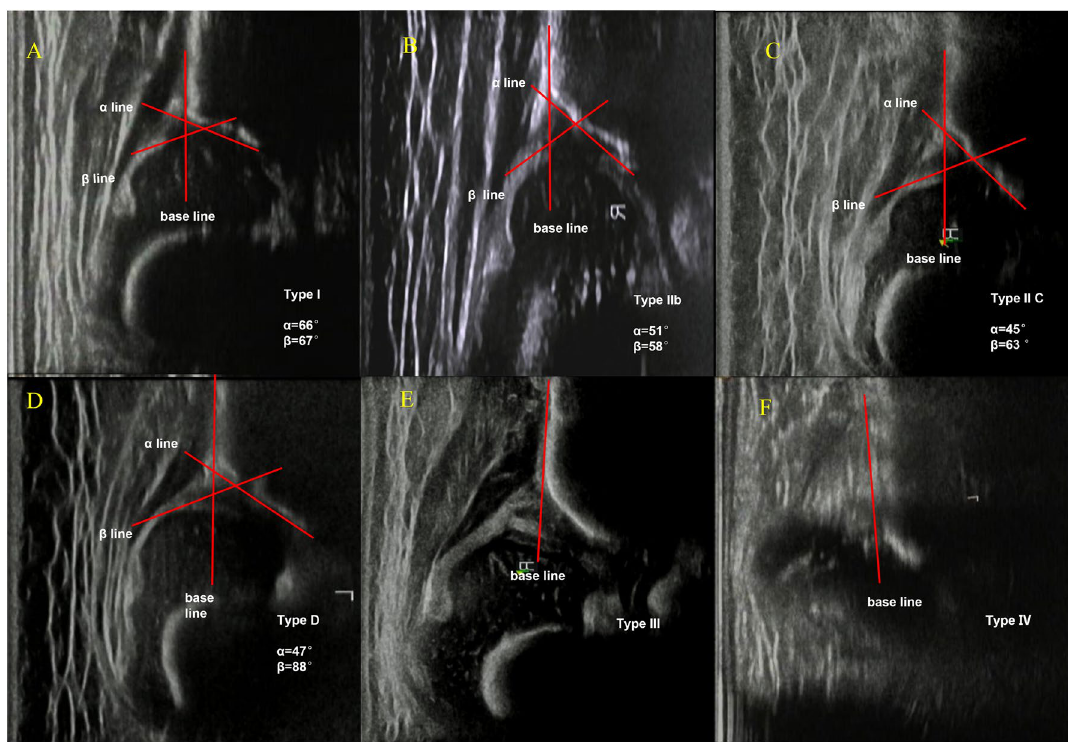
Figure 2. Graf technique for classifying different types of developmental dysplasia of the hip. A shows the Graf type technique for a 2-month-old female infant. B shows the Graf type IIb technique for a 3-month-old female infant. C shows the Graf type IIc technique for a 2-month-old female infant. D shows the Graf type D technique for a 3-month-old female infant. E shows the Graf type III technique for a 3-month-old female infant. F shows Graf type IV technique for a 3-month-old female